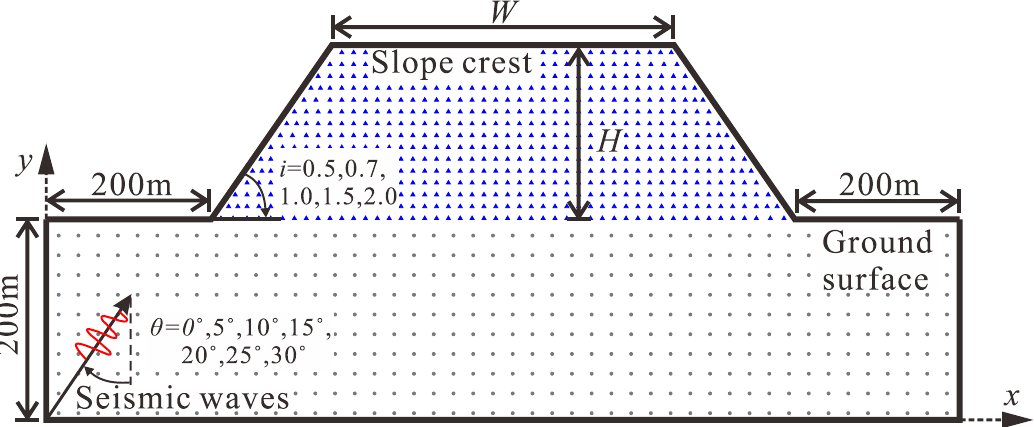
Figure 1. Sketch of the calculated modeling.